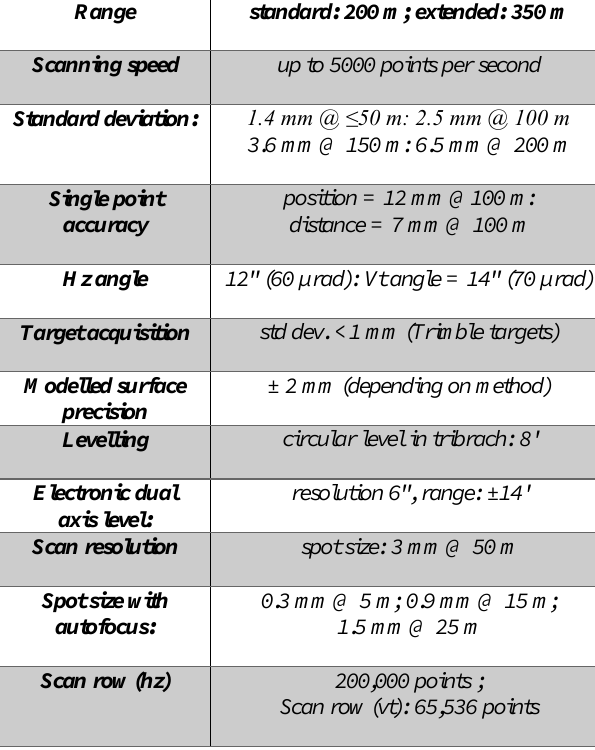
Table 1. Technical specifications of terrestrial laser scanner: Trimble GX 200